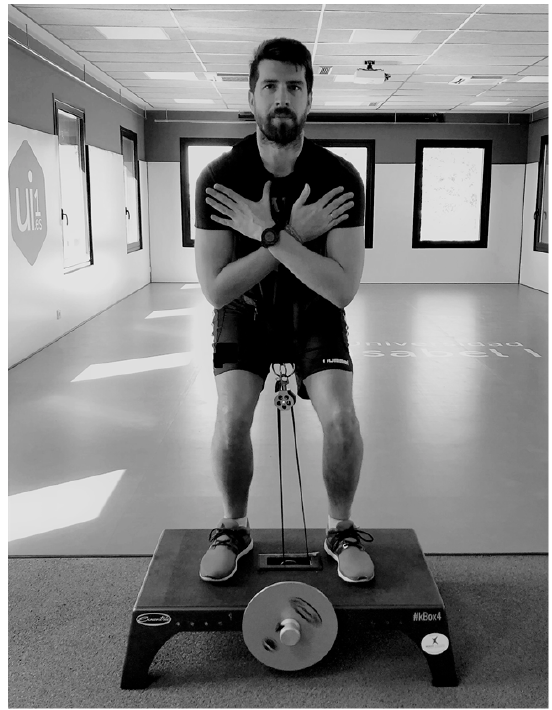
Figure 2. Description of the half-squat exercise using a non-gravity-dependent flywheel inertial de- vice.